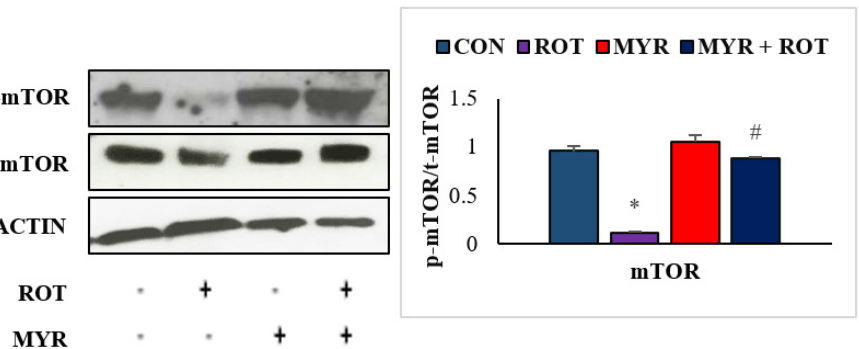
Figure 5. The effect of myrcene on the expression of α -synuclein, a protein playing a role in PD, and autophagy markers; Beclin-1, LC3B, and p62. The values are expressed as percent mean ± SEM ( n = 3). * p < 0.05 (ROT vs. CON), # p < 0.05 (MYR vs. ROT).